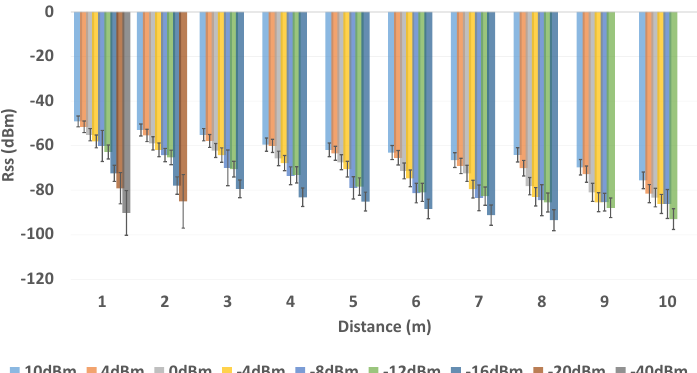
Figure 7. BLE RSS (dBm) with Multiple Transmission Power Level in Environment